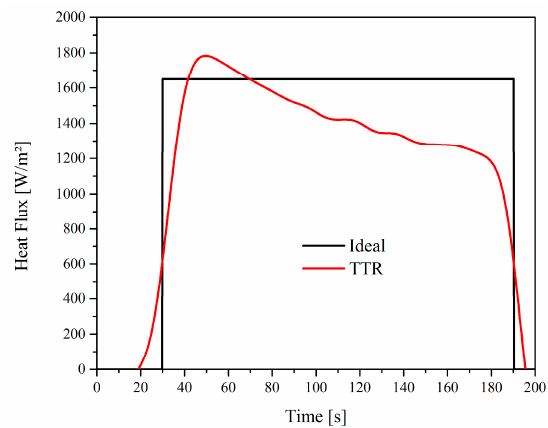
Figure 11. Estimated heat flux for r = 60.